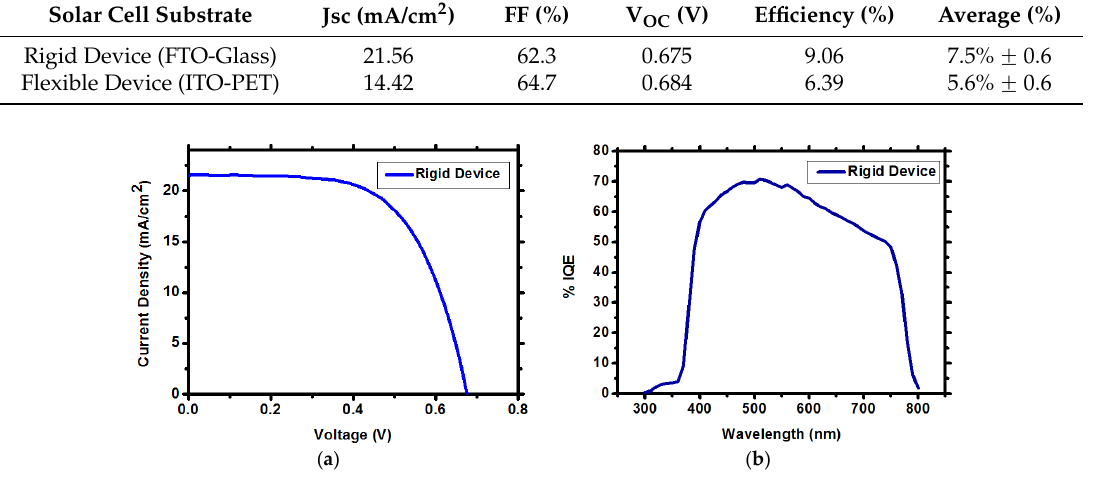
Figure 4. ( a ) IV curves of the ZnO NWs CH 3 NH 3 PbI 3 perovskite solar cell on rigid substrate; ( b ) IQE spectra of the corresponding rigid solar cell.